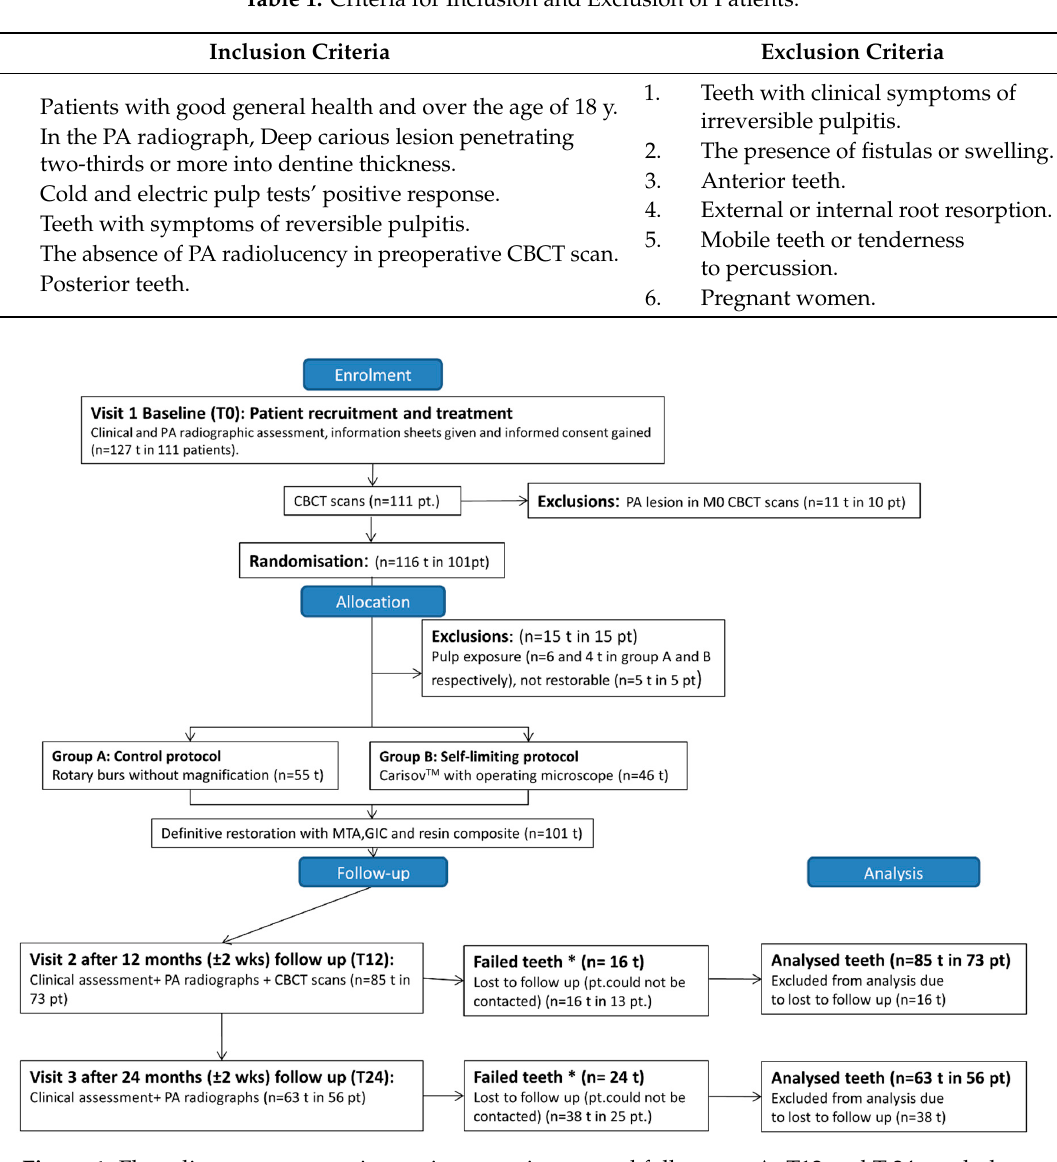
Figure 1. Flow diagram representing patient recruitment and follow-up. At T12 and T 24, teeth that have no response to pulp sensibility tests or have a radiolucency in the periapex or received root canal treatments categorized as failed teeth.